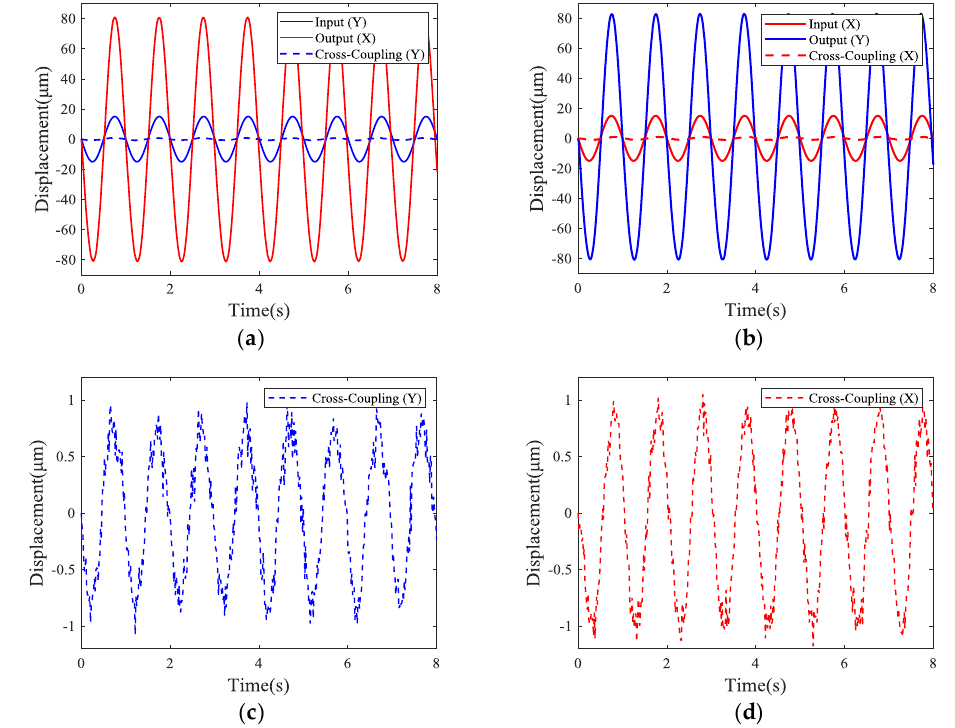
Figure 18. Experimental performance of the stage in the X-axis: ( a ) Output displacement under Y-axis actuation, ( c ) Cross-coupling error in Y-axis; as well as performance in the Y-axis: ( b ) Output displacement under X-axis actuation, ( d ) Cross-coupling error in the X-axis.